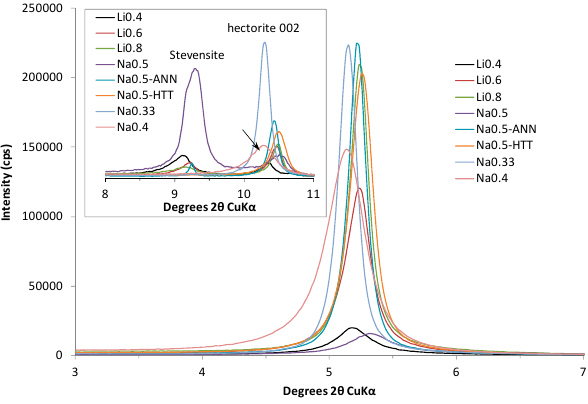
Figure 3. XRD traces of the synthetic Mg-Li smectite samples from first and second sample sets after heating at 500 °C and subsequent EG solvation.